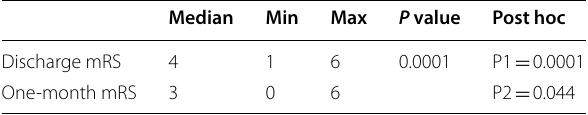
Table 3 Paired comparison of modified Rankin Scale on